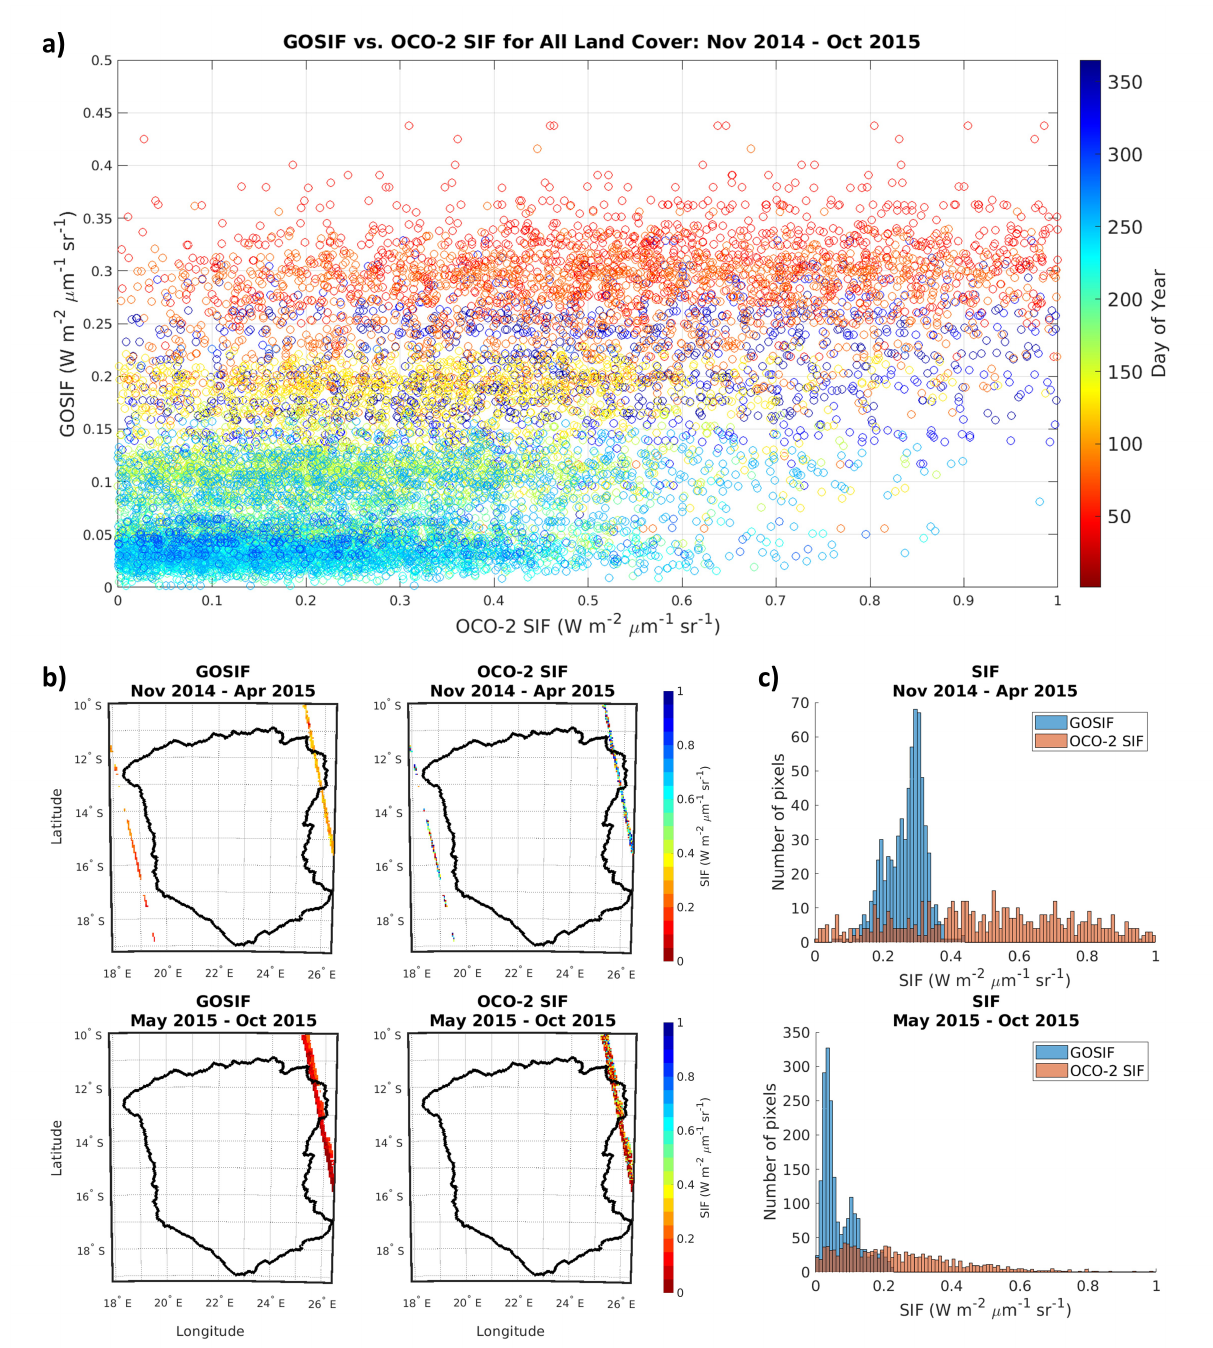
Figure 11. Global ’OCO-2’ Solar-Induced chlorophyll Fluorescence (GOSIF) vs. Orbiting Carbon Observatory-2 (OCO-2) orbit-based comparisons. ( a ) Cloud bias plot depicting pixels for all land cover types between 2014–2015. ( b ) Spatial comparisons of GOSIF and OCO-2 orbits and ( c ) histogram comparisons of the distribution of nadir-only, clear skies SIF observations. OCO-2 data here are corrected with a daytime-only daily correction factor, while GOSIF data are corrected with a 24 h daily correction